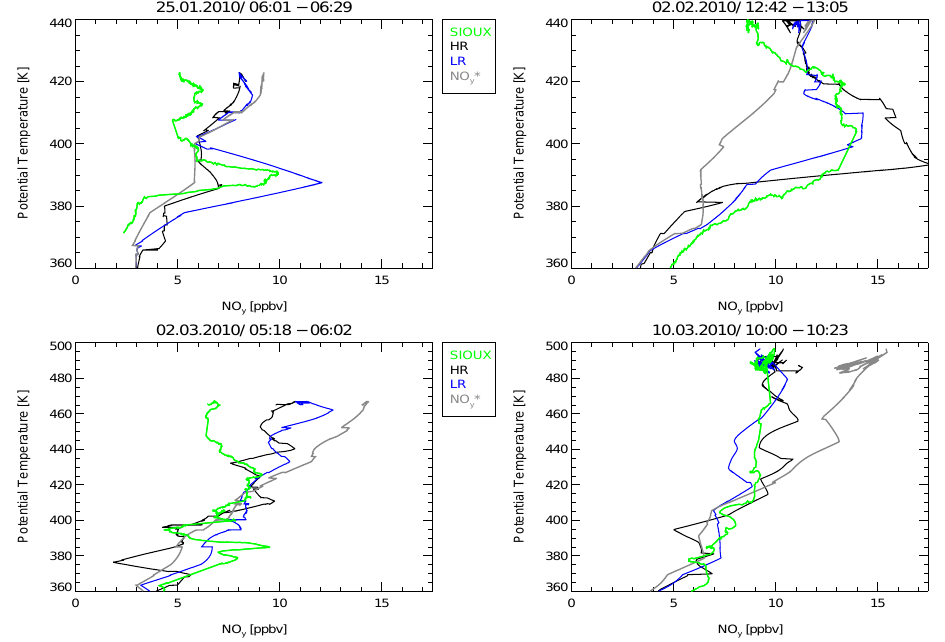
Fig. 14. Comparison of CLaMS NO y mixing ratio profiles with SIOUX data measured aboard the Geophysica aircraft. Four profiles are shown with NO y observations inside the vortex for different flights (for date and times see panel titles). SIOUX data are displayed as green lines. CLaMS results are displayed for two different simulations, the high resolution (HR, black) and the low resolution (LR, blue). The passive tracer NO ∗ y from CLaMS is shown as a grey